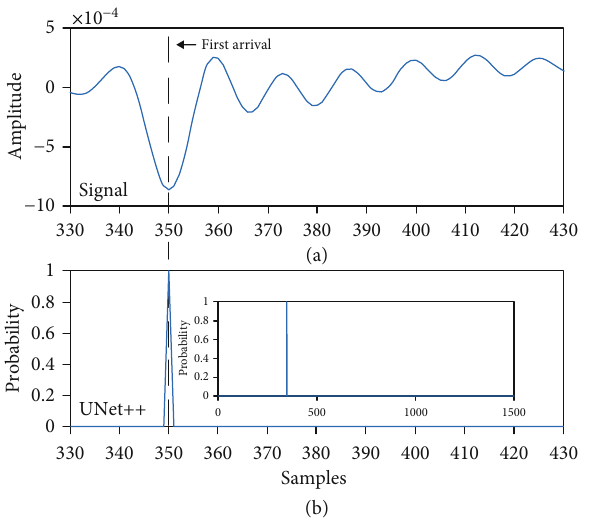
Figure 11: First-arrival picking result of the forward modeling signal with -5-dB Gaussian noise added. (a) Local ampli fi cation of the signal waveform in the range from 330ms to 430 ms. (b) The picking result in the range from 330ms to 430 ms obtained by the UNet++.